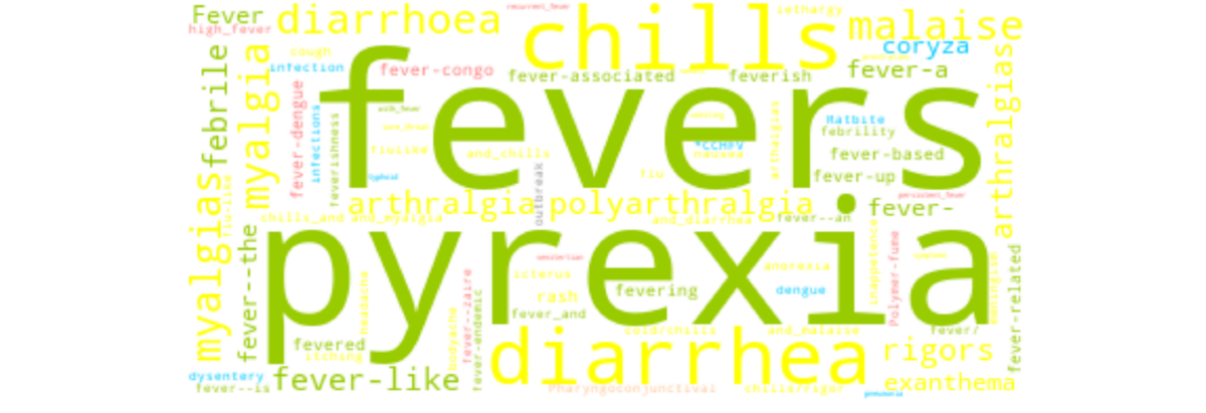
Figure 5. Word cloud depicting each returned term for “fever.” Colors correspond to semantic class